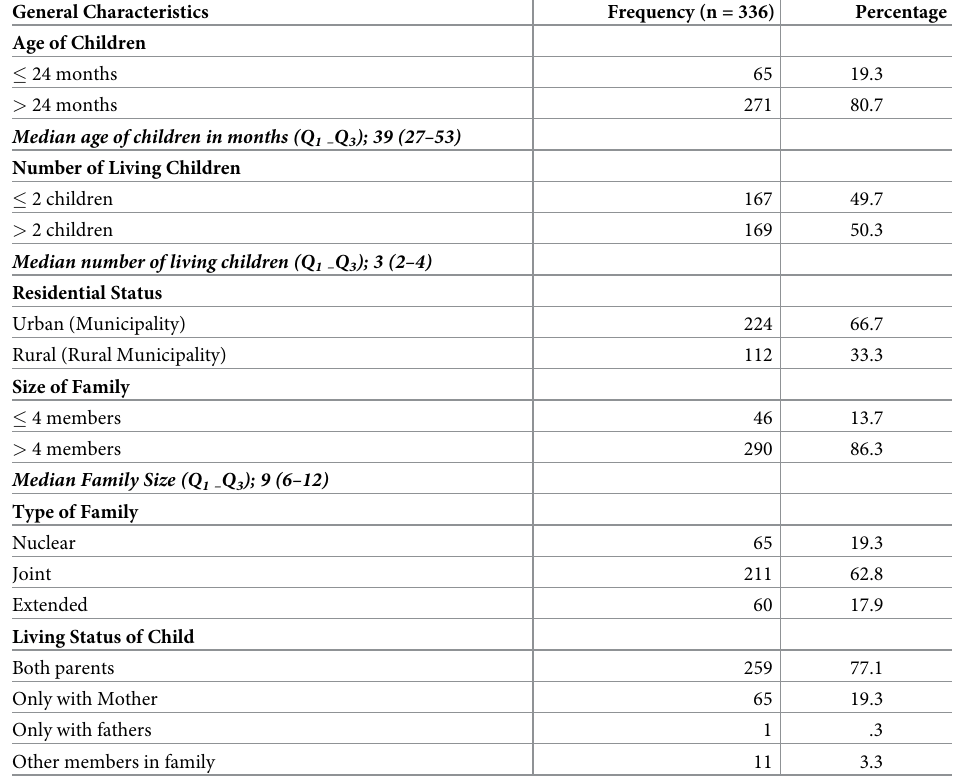
Table 1. Socio-demographic characteristics of mothers of under-five Muslim children in Kapilvastu district Nepal. General